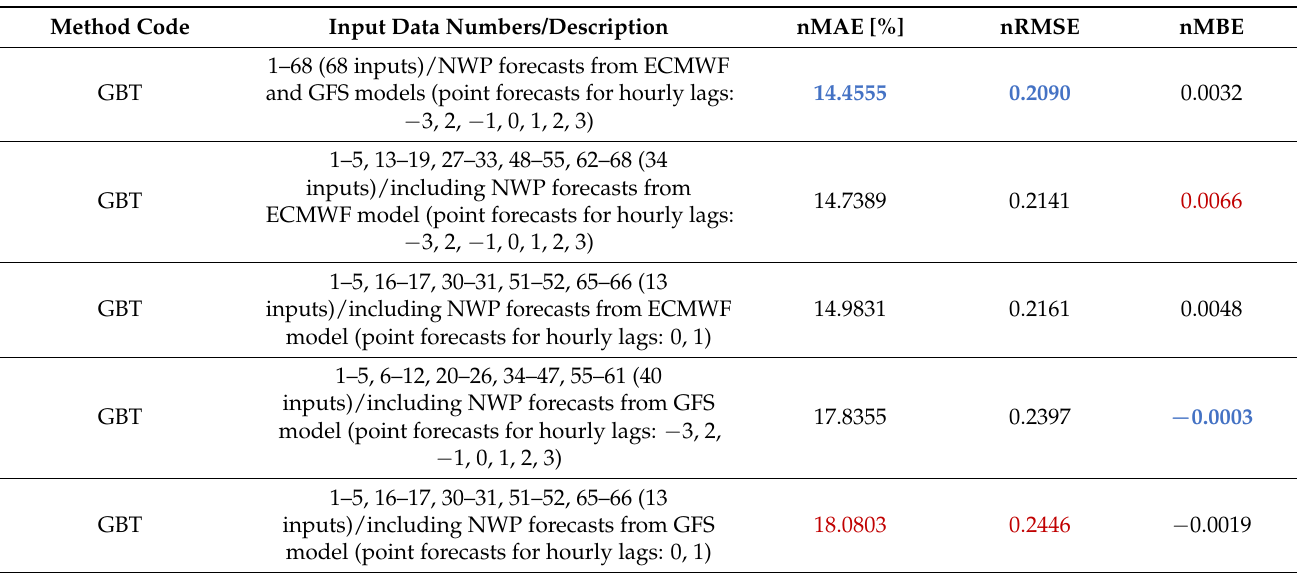
Table 8. Measures of performance of the proposed GBT method, with different versions of NWP input data (test subset) for Wind Farm